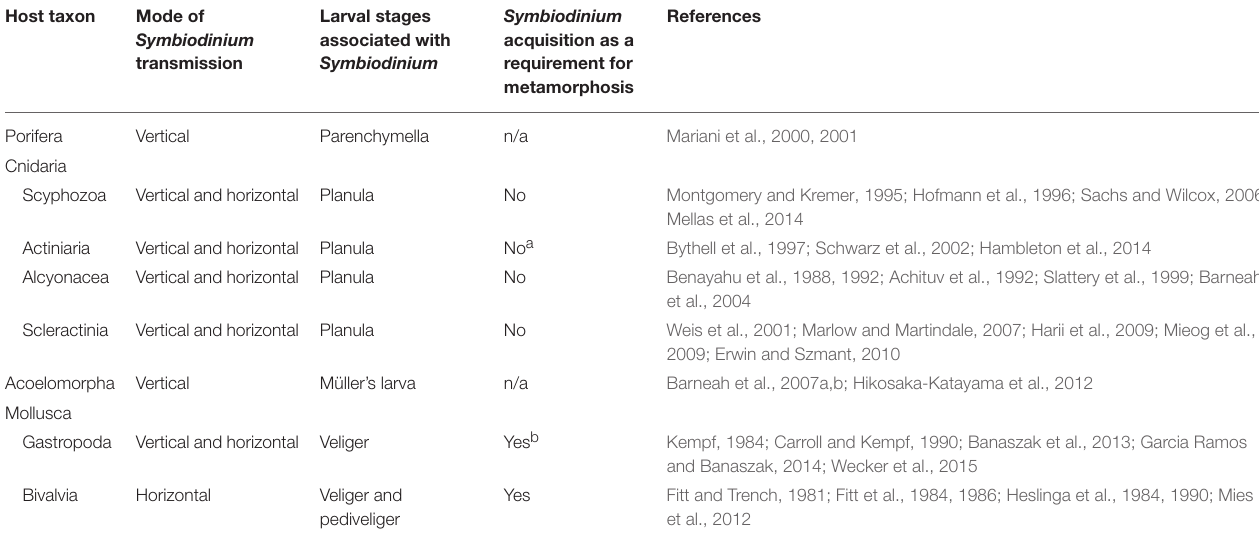
TABLE 1 | Host taxa and their larval stages associated with Symbiodinium , also describing mode of symbiont transmission and addressing whether the presence of Symbiodinium in larval tissues is critical for successfully attaining metamorphosis.